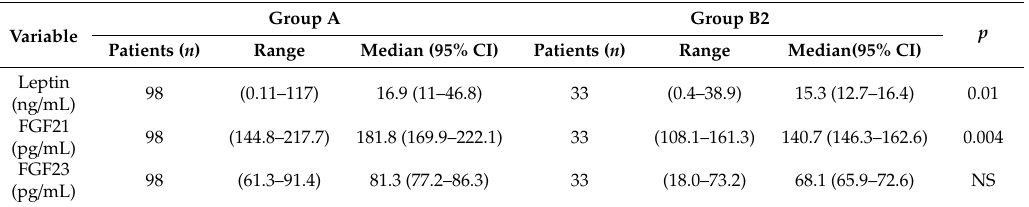
Table 5. Concentration distribution of examined proteins in endometrium cancer and subgroups with endometrial polyps.